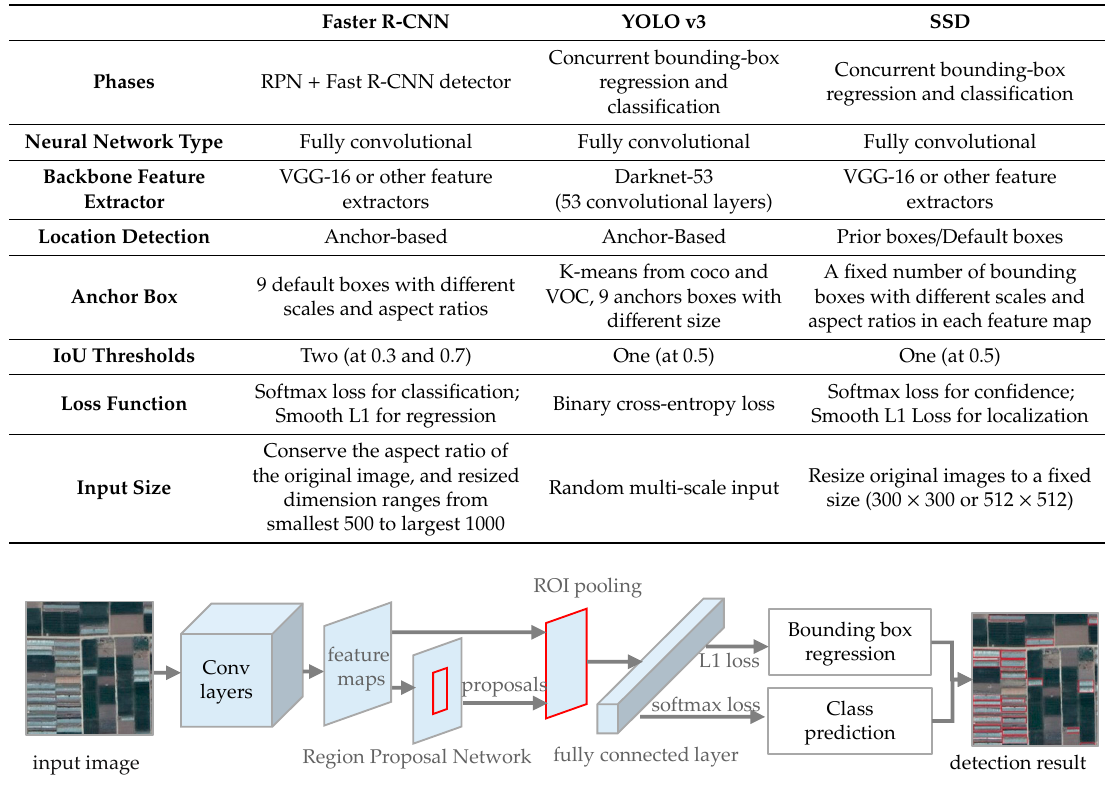
Figure 2. Architecture of Faster R-CNN in detecting AGs.